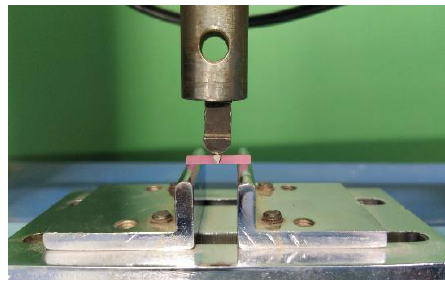
Fig 2: Measurement of